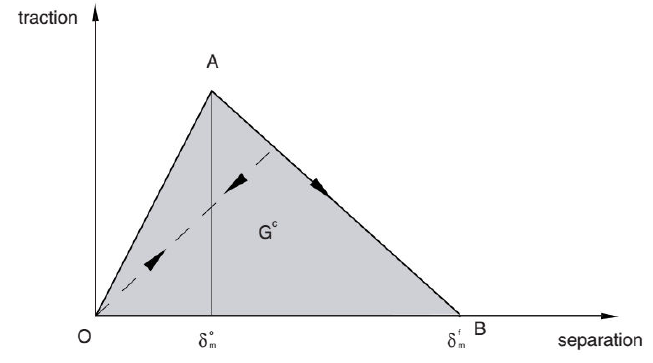
Figure 5. Linear elastic adhesion–separation viscous behavior of progressive damage failure.